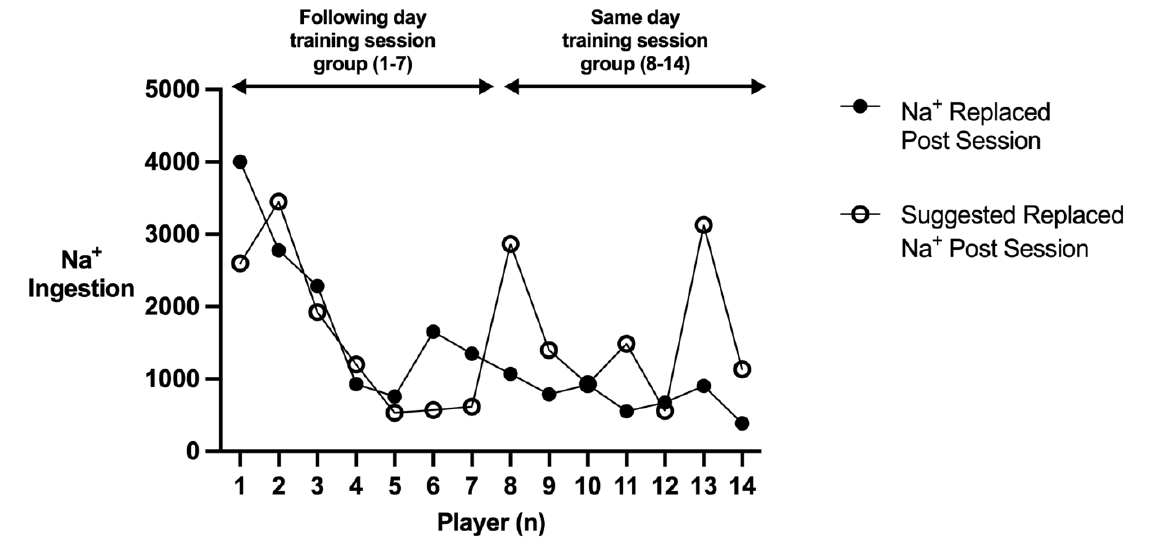
Figure 5. Players post session fluid ingestion in relation to their suggested post session fluid ingestion.